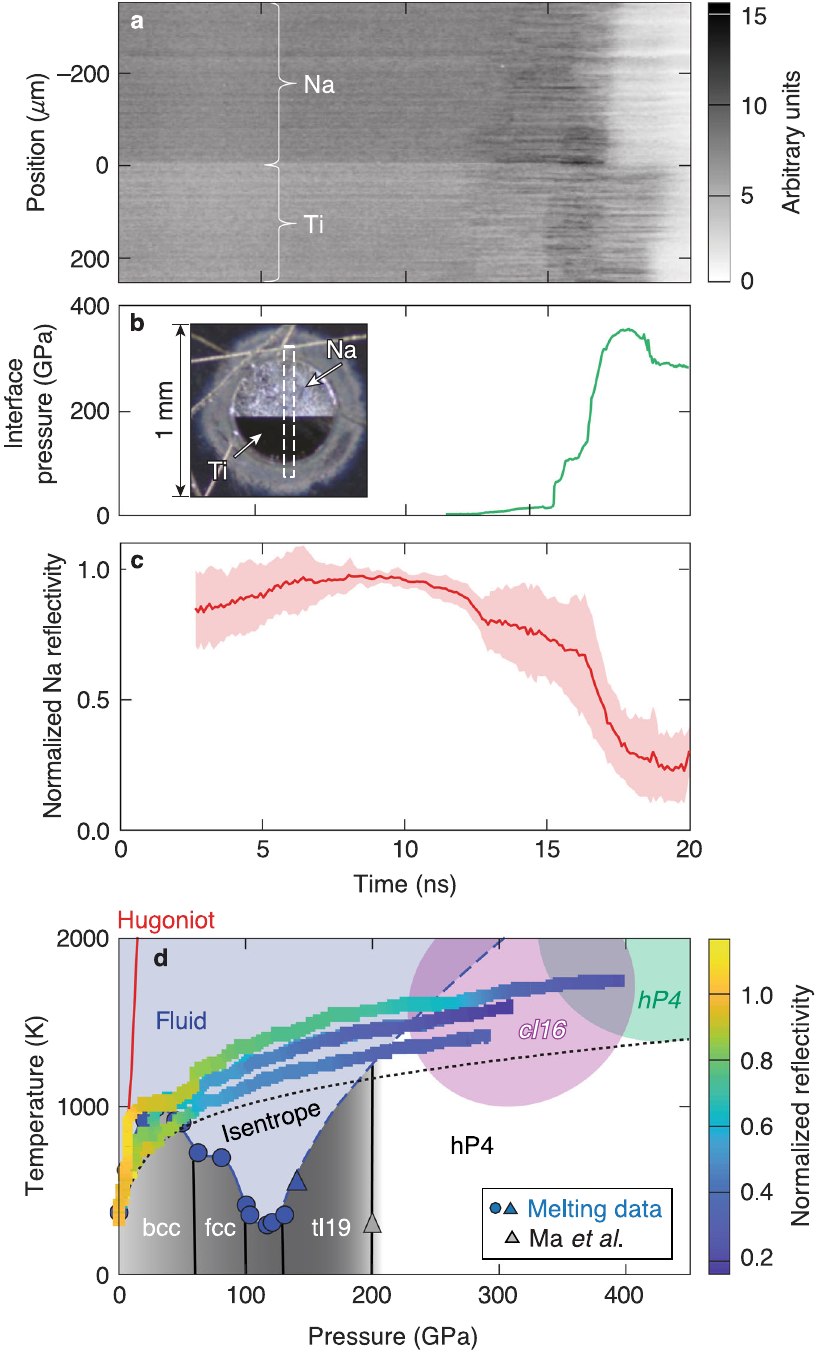
Fig. 5 Re fl ectivity data. a A non-fringing VISAR image for a Na target using a transparent MgO window and containing Ti coatings to detect changes in re fl ectivity (shot 27971). The non-fringing image is generated by blocking one arm of the VISAR interferometer, and shows no evidence of the preimposed striped re fl ectance pattern with 150 μ m period behind the Na layer. b (inset) A microscope image through the high-Z pinhole shows the Na layer (top) and the half-Ti overcoat (bottom) with the VISAR fi eld of view overlaid (dashed-box). The interface pressure of the shot shown in ( a ) shows that the drop in re fl ectivity is coincident with the increasing pressure. c Average (red) and standard deviation (red shaded region) of all Na re fl ectivity data normalized to the Ti re fl ectivity behind the transparent window. d The temperature-pressure phase diagram of Na with the simulated ramp-compression path (multicolor curves) for three re fl ectivity